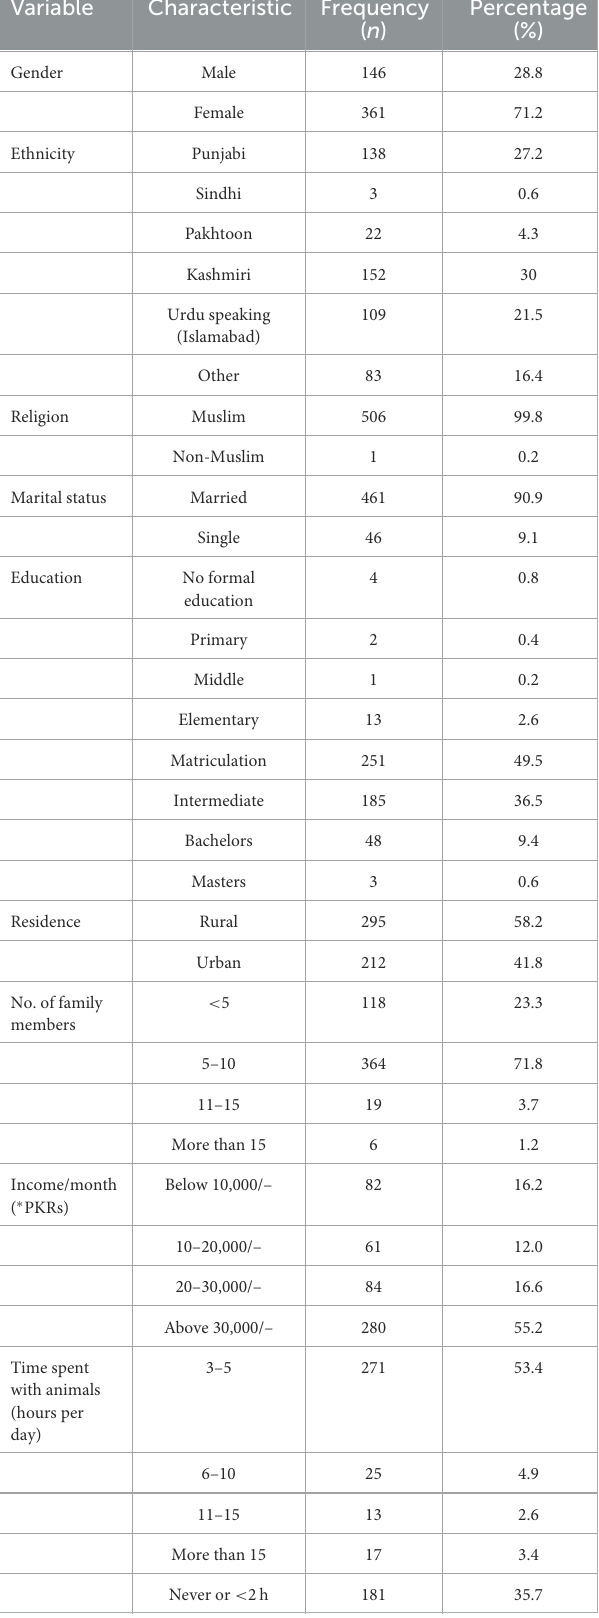
TABLE 1 Participants’ socio-demographic characteristics.